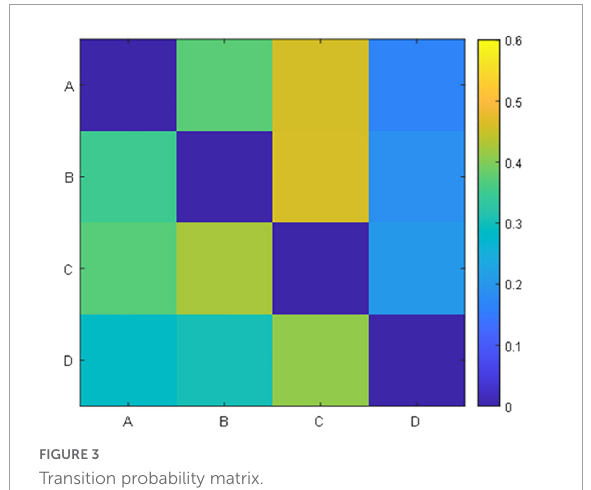
FIGURE3 Transition probability matrix.